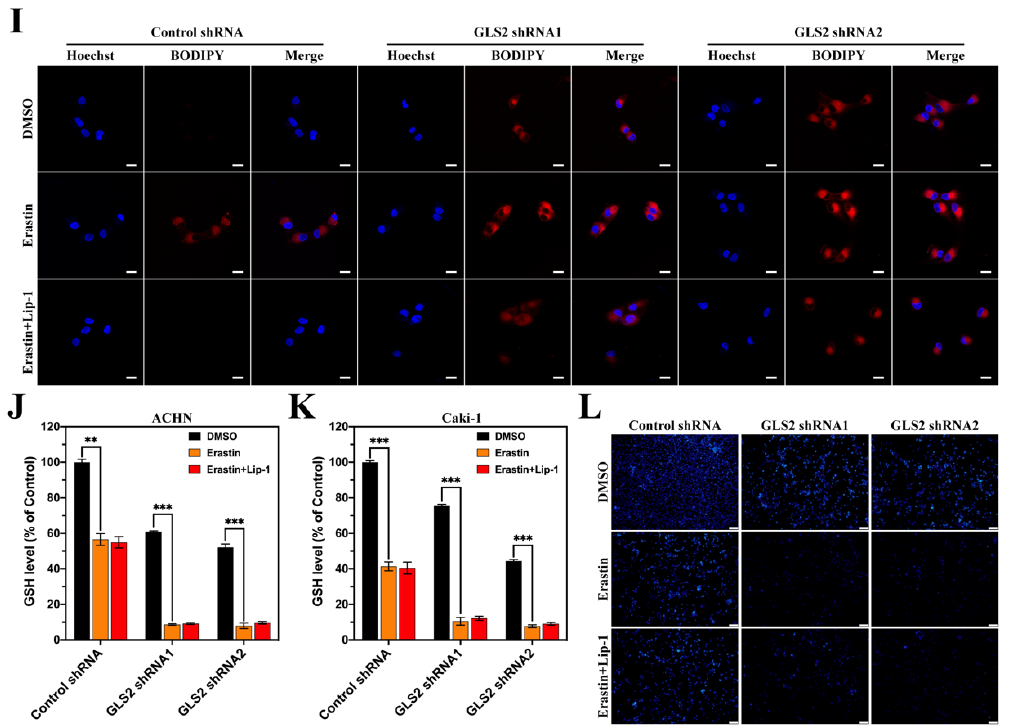
Figure 9. GLS2 might be a suppressor of ferroptosis in ccRCC. ( A ) The mRNA expression of GLS2 with different shRNAs treatments in ACHN. ( B ) The proteomic expression of GLS2 with different shRNAs treatments in ACHN. ( C ) The mRNA expression of GLS2 with different shRNAs treatments in Caki-1. ( D ) The proteomic expression of GLS2 with different shRNAs treatments in Caki-1. ( E , F ) The cell viabilities and MDA levels of ACHN treated with erastin (10 µ M, 12 h) in the absence or presence of Lip- 1 (1 μM). ( G , H ) The cell viabilities and MDA levels of Caki-1 treated with erastin (10 μM, 12 h) in the absence or presence of Lip - 1 (1 μM). ( I ) Lipid peroxidation of ACHN with various treatments (Nuclei were stained with Hoechst 33342, and lipid peroxides were stained with BODIPY 665/676). The scale bar represented 20 μm. ( J ) GSH levels of ACHN treated with erastin (10 μM, 12 h) in the absence or presence of Lip - 1 (1 μM). ( K ) GSH levels of Caki-1 treated with erastin (10 μM, 12 h) in the absence or presence of Lip - 1 (1 μM). ( L ) The status of intracellular GSH levels was assessed by MBB staining in ACHN treated with erastin (10 μM, 12 h) in the absence or presence of Lip- 1 (1 μM). The scale bar represent s 100 μm . (* p < 0.05, ** p < 0.01, *** p < 0.001).